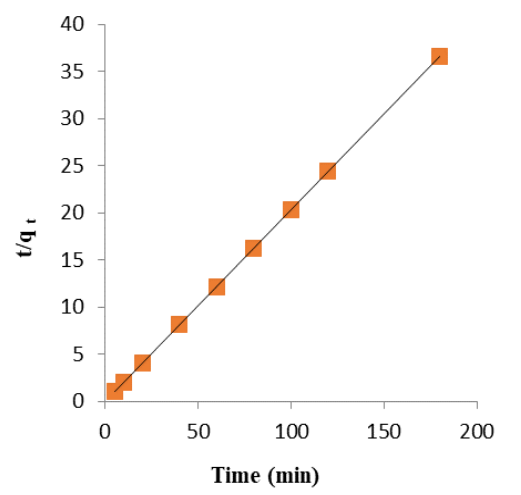
Fig. 7. Pseudo-first-order kinetic modeling of Cd 2+ adsorption onto SEZ at initial concentration 10 mg/L (25 ± 0.2 °C)